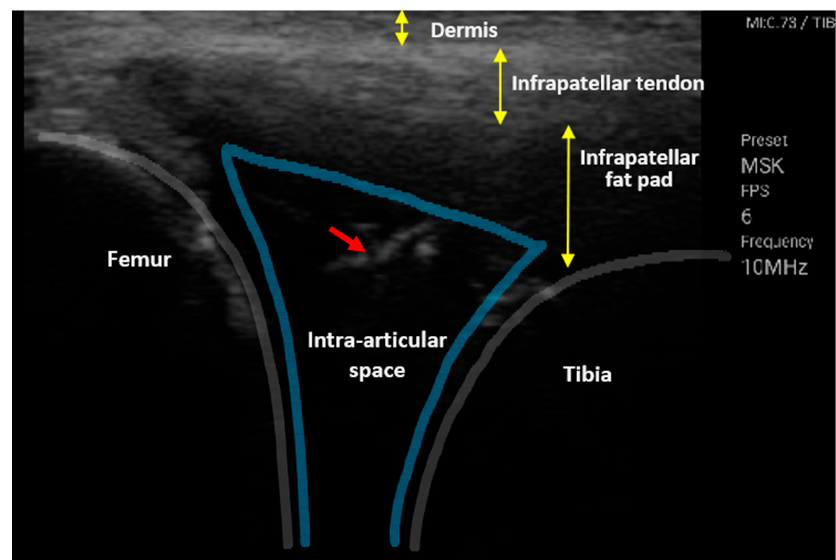
Figure7. Ultrasonographyimagethatwascapturedwhentheneedleelectrodeenteredtheintra-articular Figure 7. Ultrasonography image that was captured when the needle electrode entered the intra- space. The red small arrow shows the needle location and the di ff erent depths of the tissue layers articular space. The red small arrow shows the needle location and the different depths of the tissue indicated by the yellow arrows. The blue boundary shows intra-articular space. layers indicated by the yellow arrows. The blue boundary shows intra-articular space.